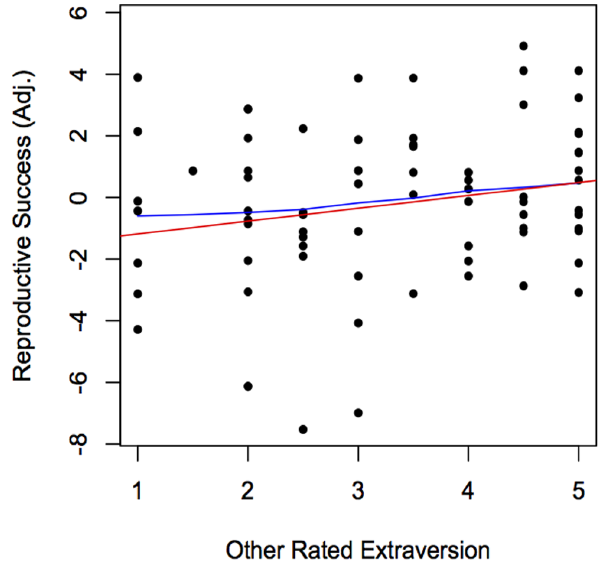
Figure 1. Extraversion and Male RS. The red line is based on the regression of RS on other rated extraversion; the blue curve is the Lowess approximation of the function. doi:10.1371/journal.pone.0059325.g001 PLOS ONE |